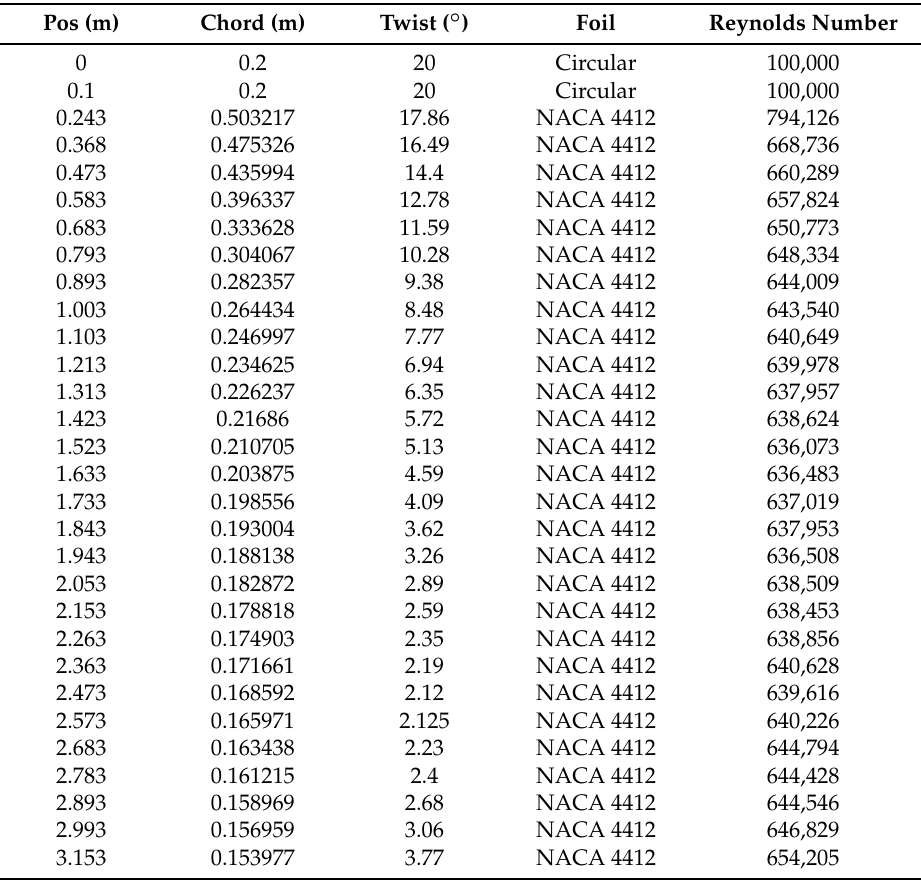
Table A3. Pitch wind turbine blade